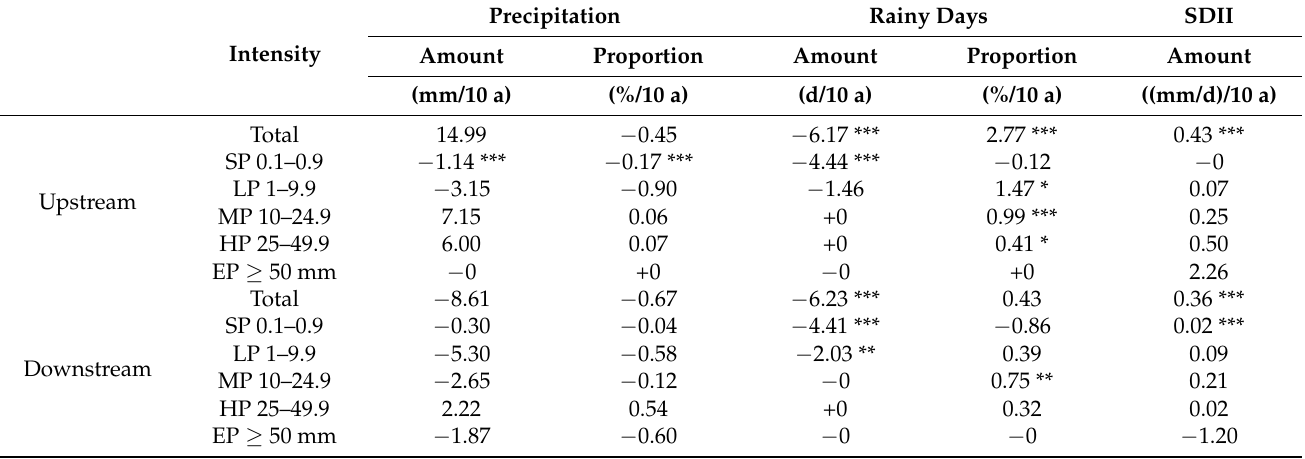
Figure 3. Monthly precipitation and rainy days in each intensity in the upper and lower basins: ( a ) precipitation and ( b ) rainy days. The pie charts show the proportion of precipitation/rainy days in the wet season (W) and dry season (D). “None” fill bar/pie is the upstream value; the dense fill bar/pie is downstream value. Table 3. Trends of precipitation, rainy days, and SDII in the wet season in each intensity over the LRB during